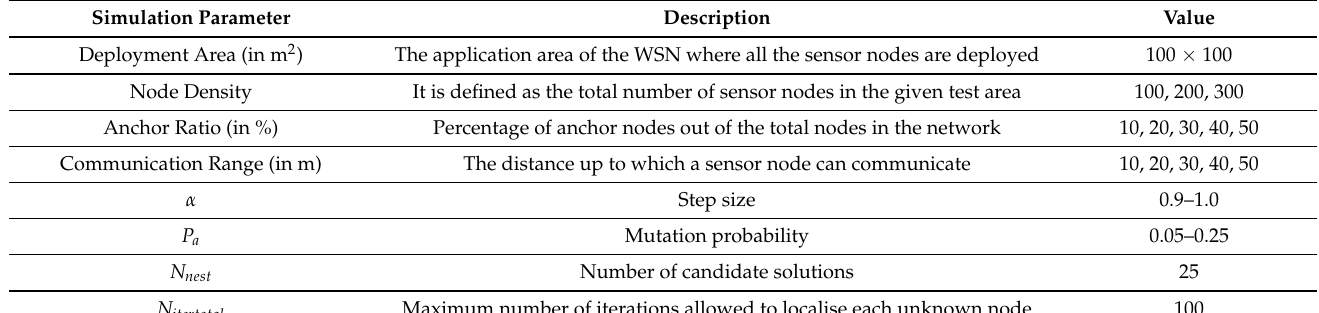
Table 1. Simulation